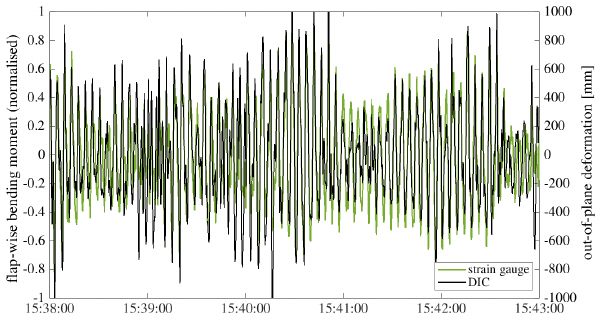
Figure 18. Qualitative comparison of measured flap-wise bending moment and OoP deformation of blade B.